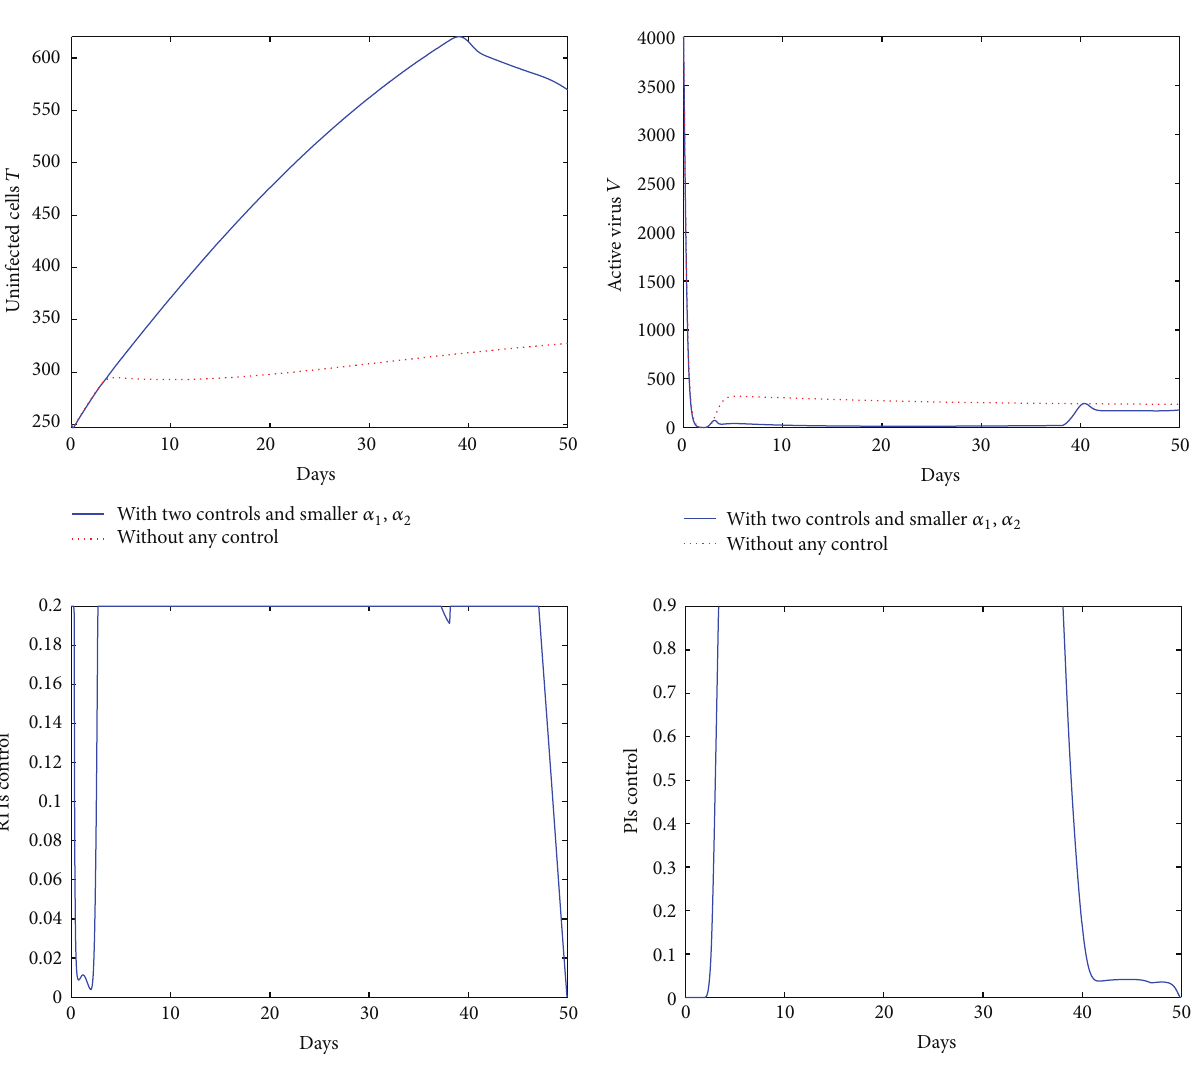
Moreover, among the strategies with effective treatment, the treatment effect using Strategy V and Strategy VI (with